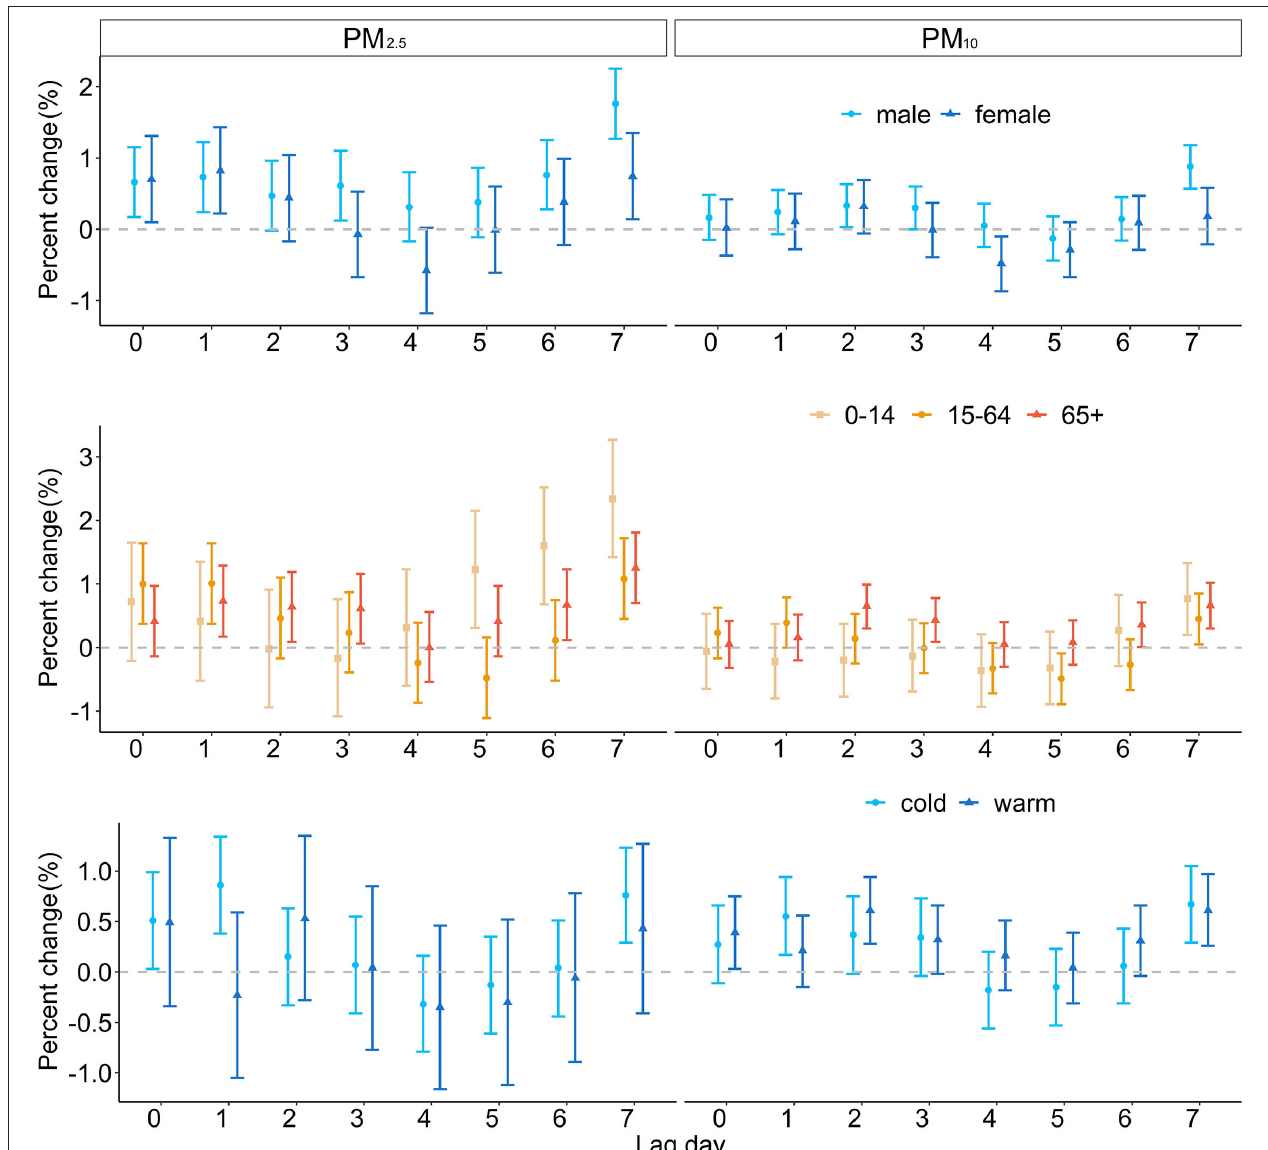
FIGURE 4 | The estimated PC of RD hospitalizations per 10 µ g/m 3 increase in PM 2.5 and PM 10 concentrations by gender, age group, and